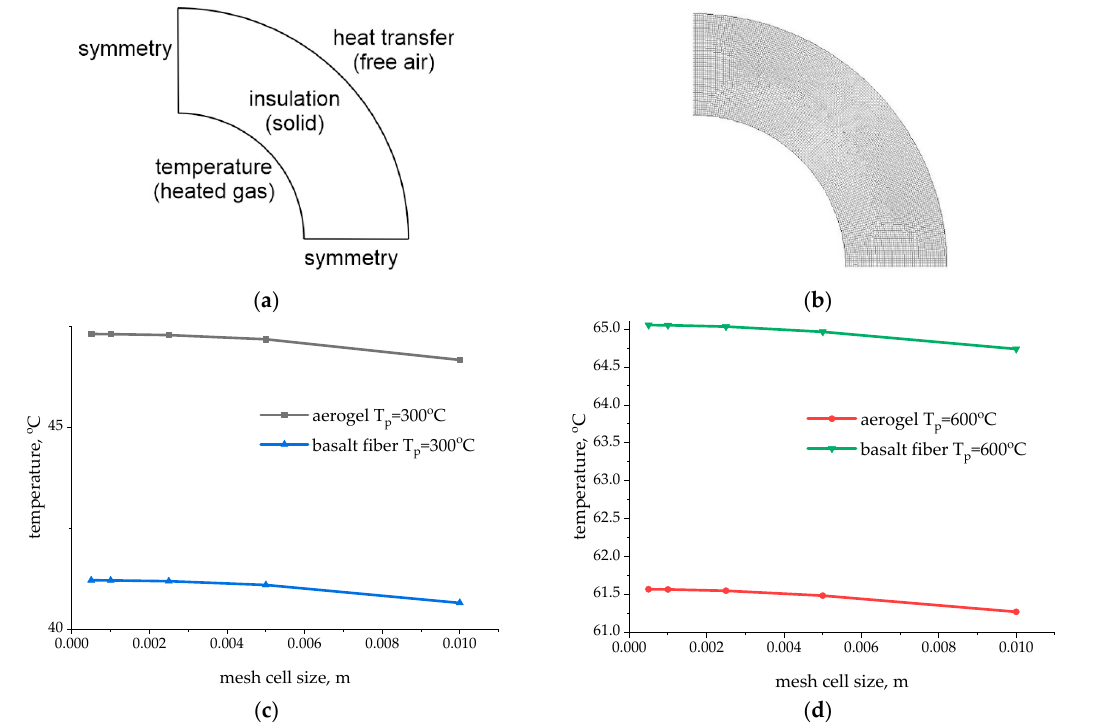
Figure 7. Parameters of numerical simulation: ( a ) Computational domain; ( b ) Mesh example; ( c ) Dependence of the temperature on the insulation surface on the size of the mesh element for the temperature of the pipe 300 °C; ( d ) Dependence of the temperature on the insulation surface on the size of the mesh element for the temperature of the pipe 600 °C.